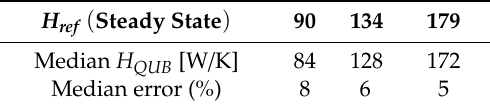
Table 2. QUB experiments at di ff erent insulation level of